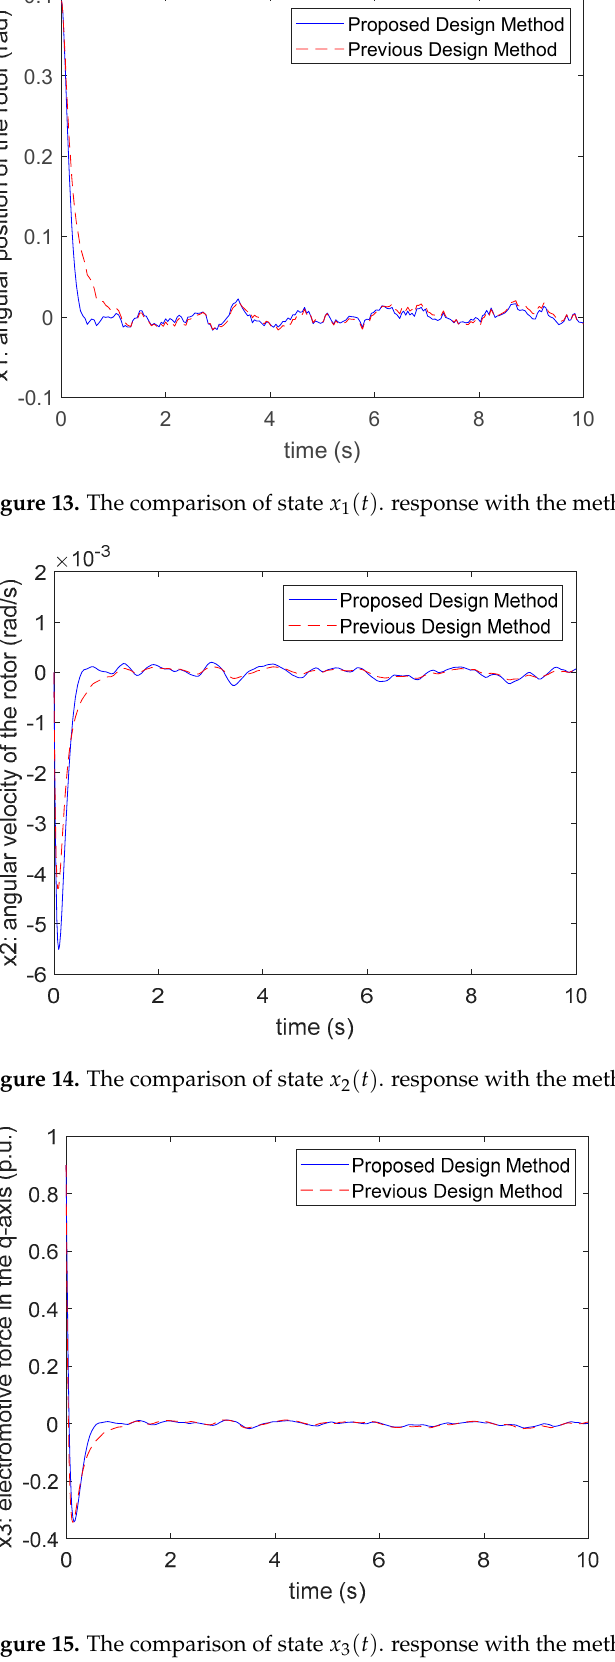
Figure 15. The comparison of state x 3 ( t ) response with the method in [28].